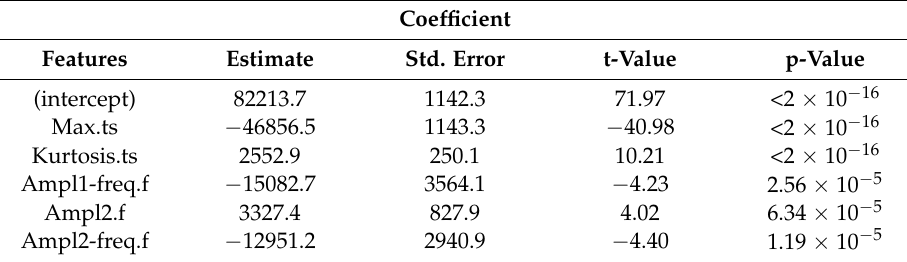
Table 5. Coefficients of the selected features.